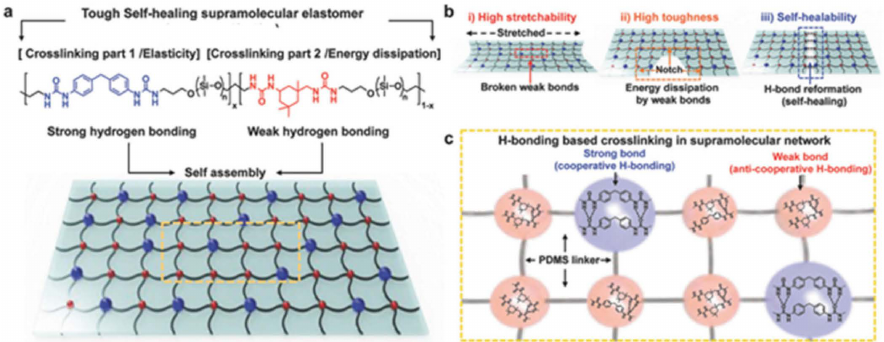
Figure 9. ( a ) Chemical structure of the elastomer and proposed ideal supramolecular structure. ( b ) Diagrams of stretched polymer film (left), notched film (middle), and healed film (right). ( c ) Possible combinations of H-bonds for strong and weak bonds, respectively. Reproduced from [127] with permission from John Wiley and Sons.